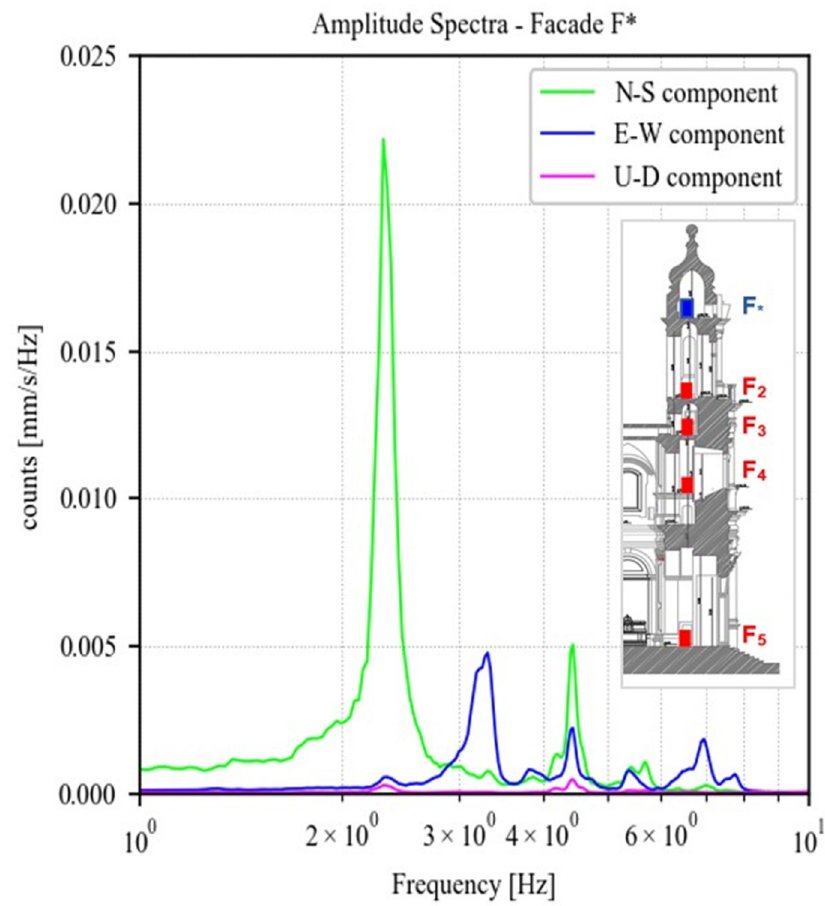
Figure 14. Amplitude of the fast Fourier spectra regarding point F* on the top of the Façade for each component (North–South, East–West, Up–Down).